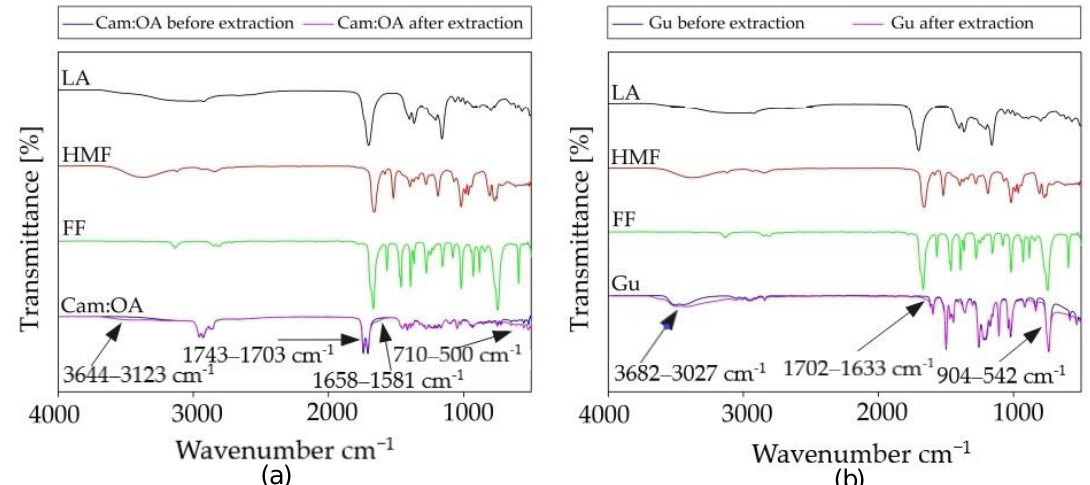
Figure 9. FT-IR spectra after the extraction process ( a ) for Cam: OA (1:1) and ( b ) for pure Gu.